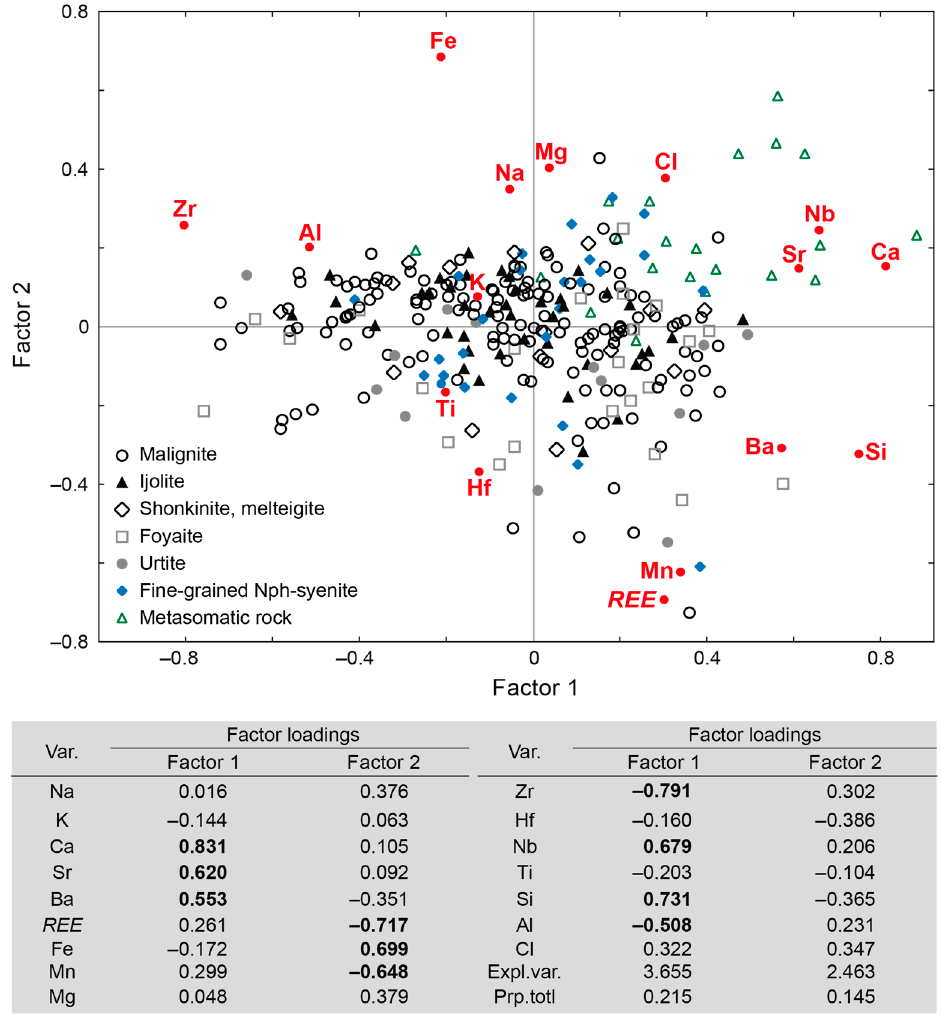
Figure 17. Results of factor analyses of EGM compositions. Var.—variables; Expl.var.—Explained variance; Prp.totl—proportion of total variance. Factor loadings > |0.5| are shown in bold.